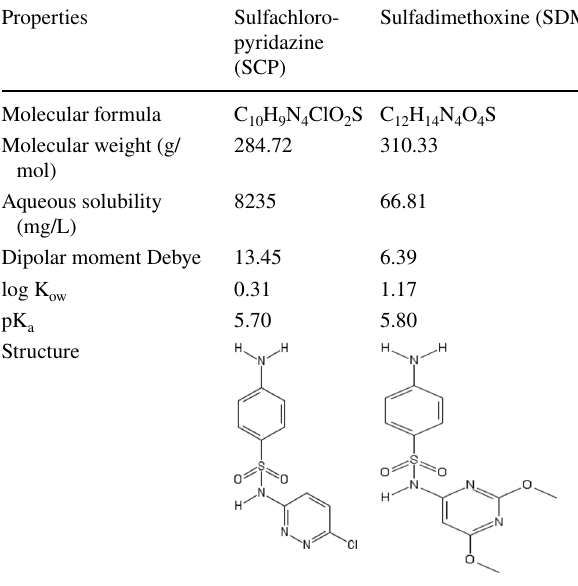
Fig. 1 FTIR spectrum for the iron-modified clay